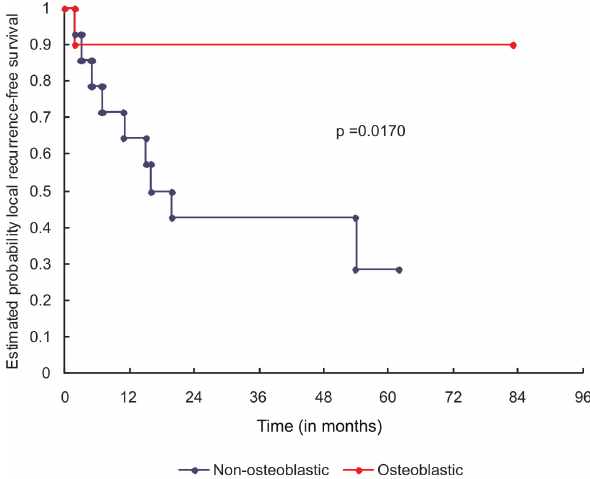
Figure 6 - Curve of local recurrence-free survival in months for the 24 patients with primary osteosarcoma that was non-metastatic at diagnosis, according to histological type